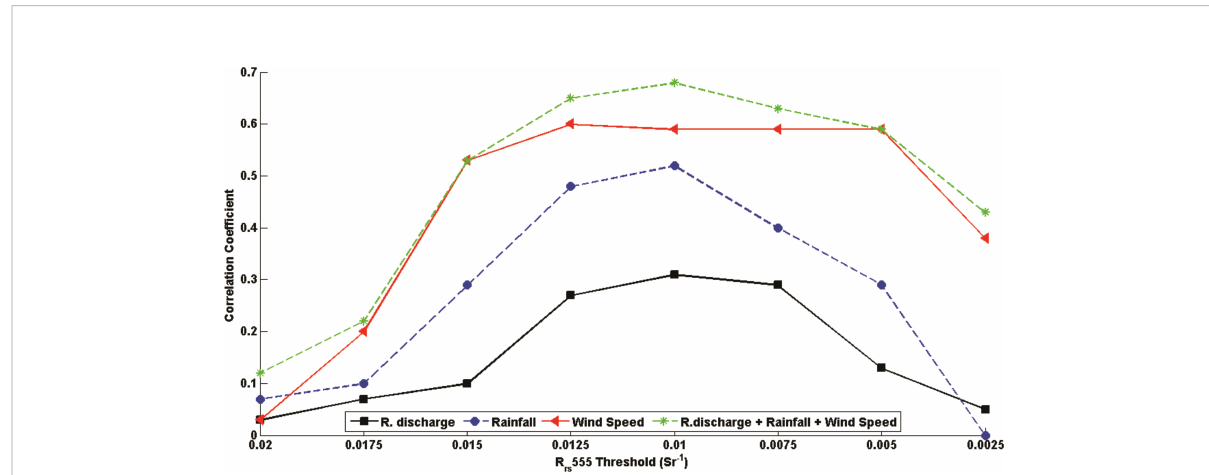
FIGURE 3 Correlation coef fi cient between plume extension for different threshold levels of R rs 555 and monthly river discharge (in black), Zambezi Delta rainfall, wind speed (in red), and combination of river discharge, Zambezi Delta rainfall, and wind speed. The threshold values vary from higher to lower value to better illustrate the natural variation of R rs 555, which decreases offshore from the coast.